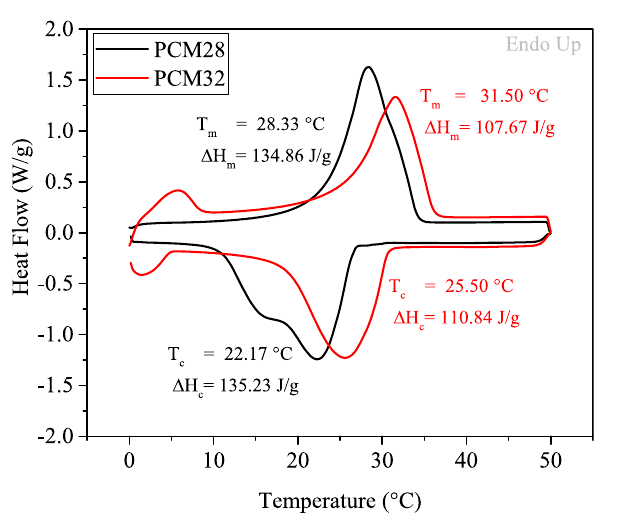
Figure 5. DSC thermograms of